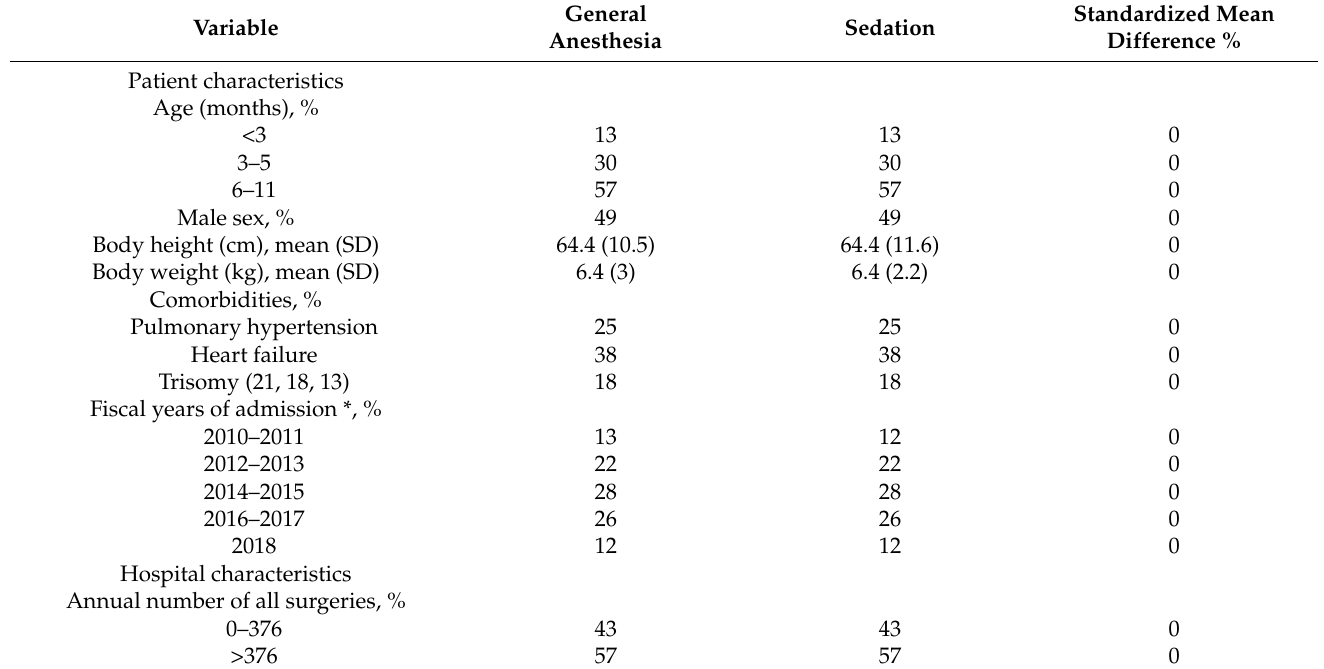
Table 2. Baseline characteristics after adjustment by overlap